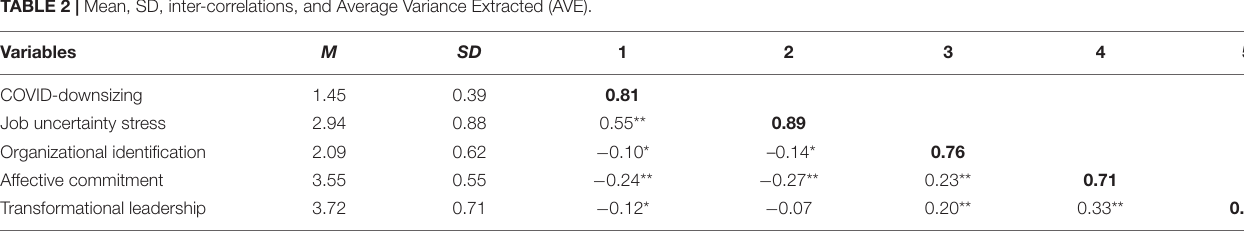
TABLE 2 | Mean, SD, inter-correlations, and Average Variance Extracted (AVE).